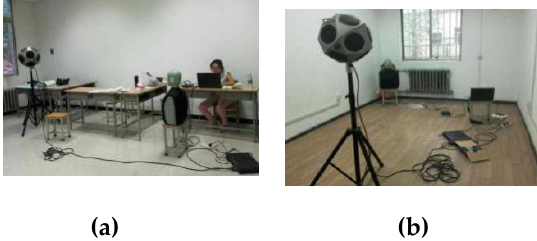
Table 2. The parameters of real rooms.